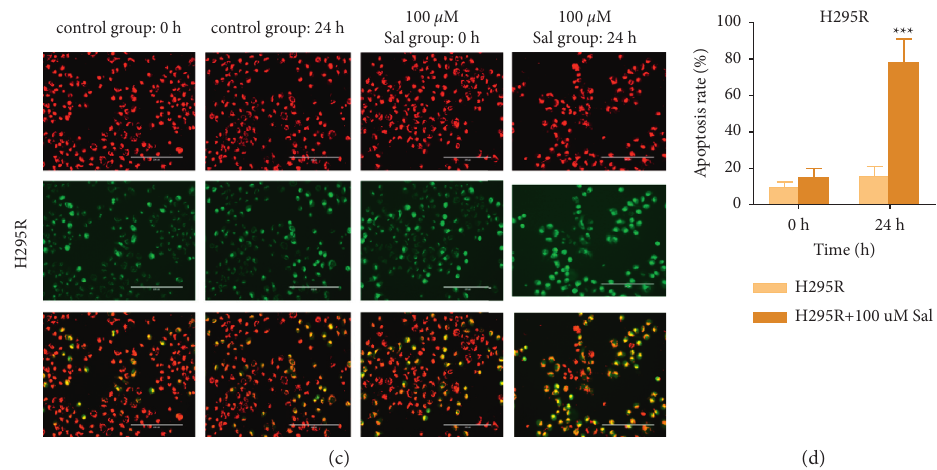
Figure 3: Sal induced apoptosis in ACC cells. (a) SW-13 cells were stained with JC-1 after being incubated in 0 μ m Sal and 100 μ m Sal for 0h and 24 h. (b) Comparison of cell apoptosis in A ∗∗∗ p < 0 . 001. (c) H295R cells were stained with JC-1 after being incubated in 0 μ m Sal and 100 μ m Sal for 0h and 24h. (d) Comparison of cell apoptosis in C ∗∗∗ p < 0 . 001. The data are expressed as means ± SD ( n �